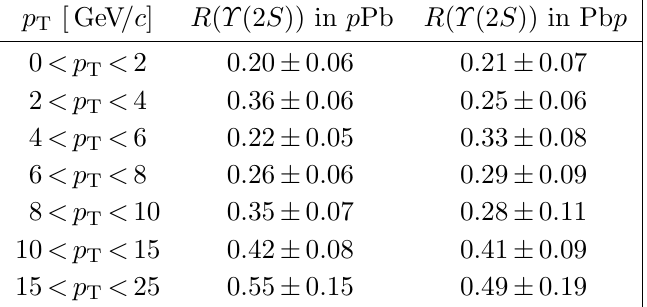
Table 18 . (cid:7) (2 S ) to (cid:7) (1 S ) ratio, R ( (cid:7) (2 S )), in p Pb and Pb p as a function of p T integrated over y (cid:3) in the range 1 : 5 < y (cid:3) < 4 : 0 for p Pb and (cid:0) 5 : 0 < y (cid:3) < (cid:0) 2 : 5 for Pb p .